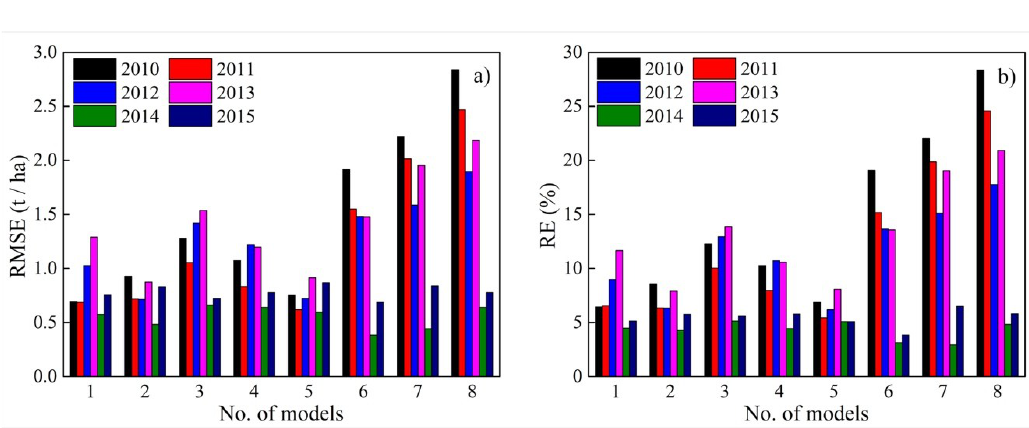
Figure 4. The RMSE ( a ) and RE ( b ) of RF models for maize yield estimation from 2010 to 2015.